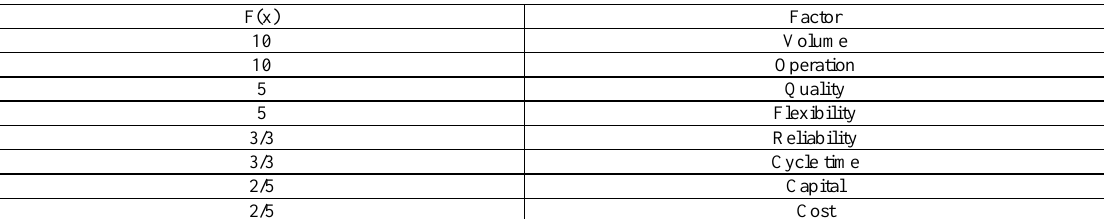
Table 3. Factors